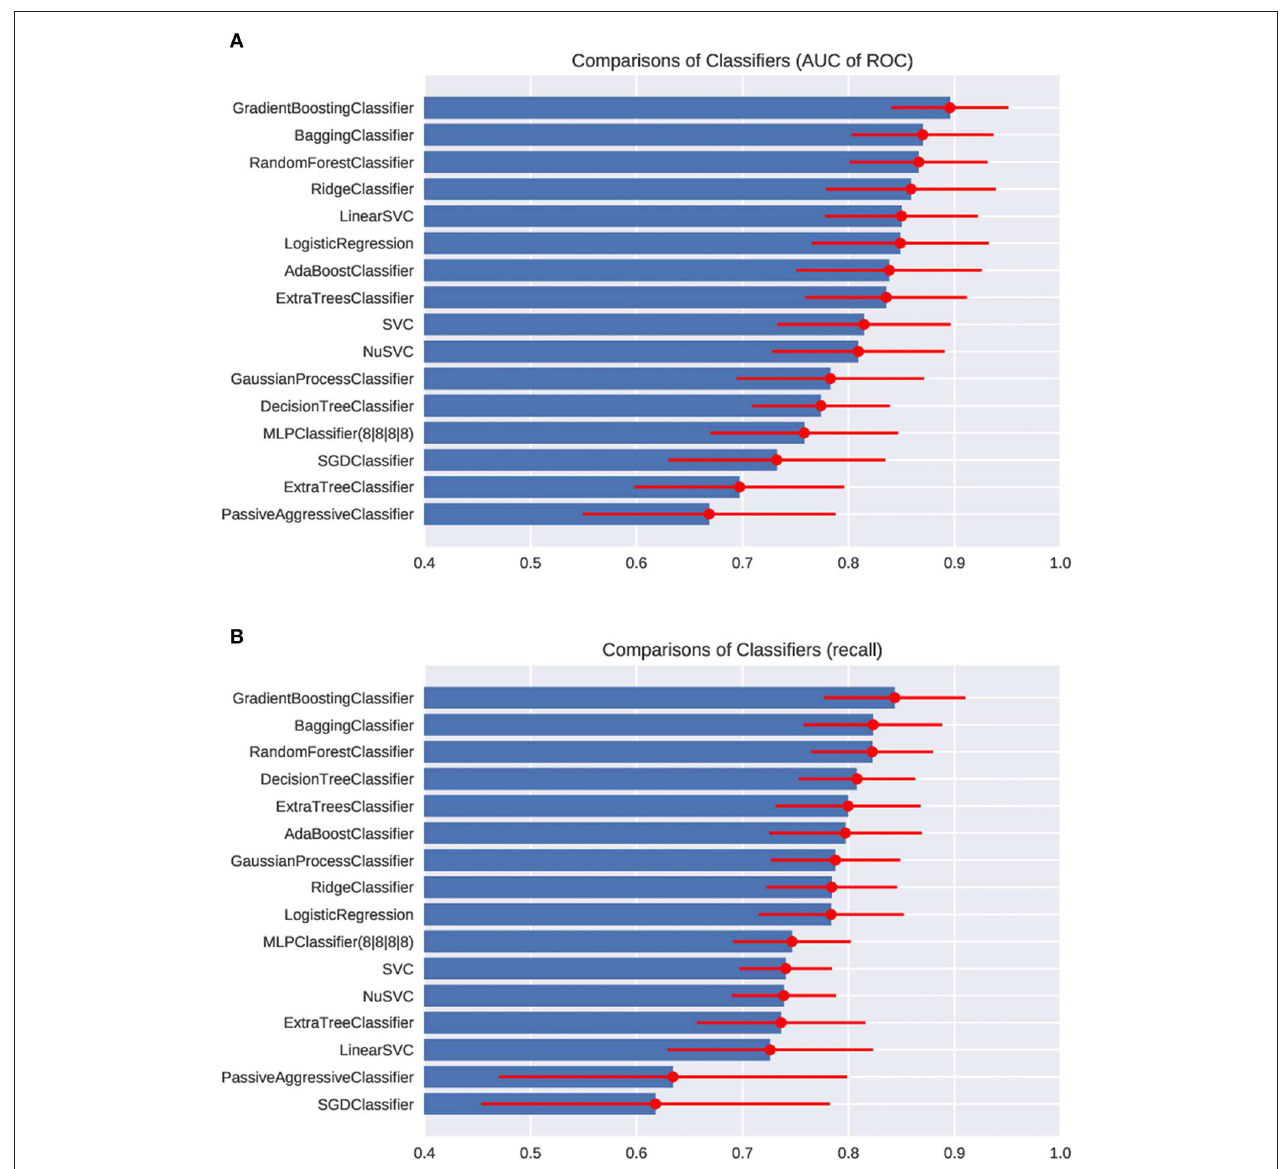
FIGURE 3 | Comparisons of classifiers in the AUC of ROC (A) and the recall (B)